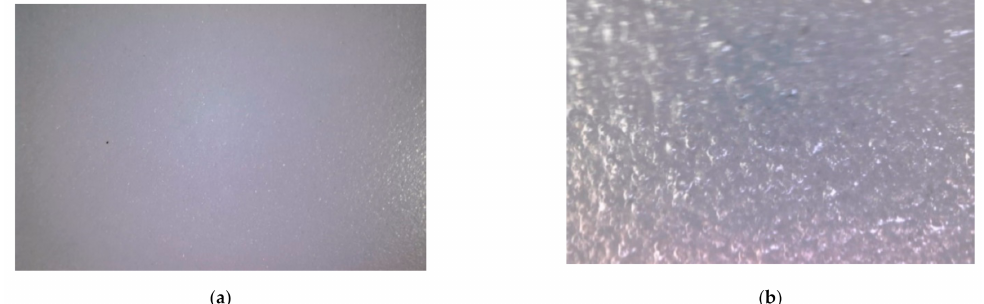
Figure 1. Microscopic image of polyurethane foil: ( a ) under a magnification of 50 × ; ( b ) under a magnification of 200 ×